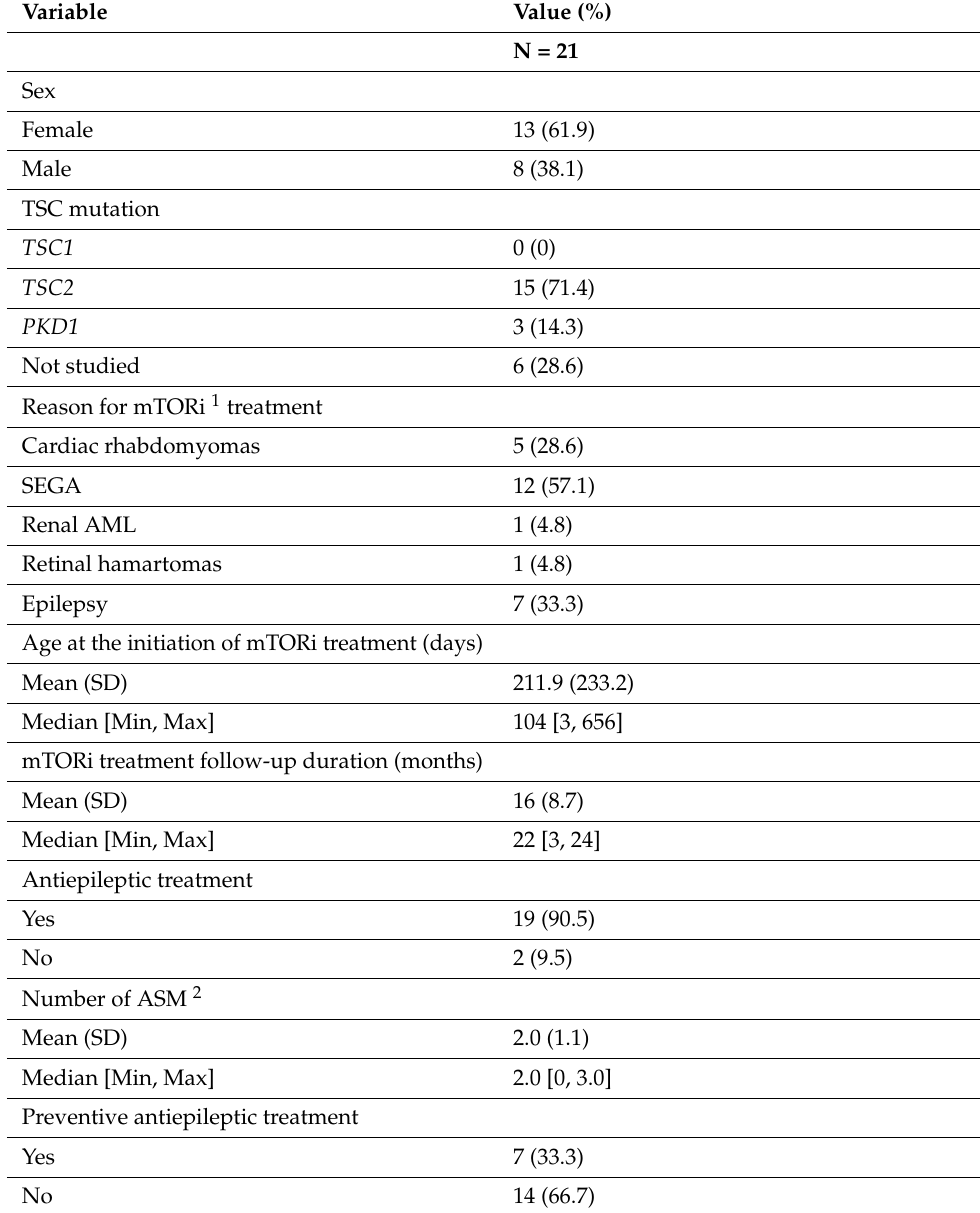
Table 1. Patients’